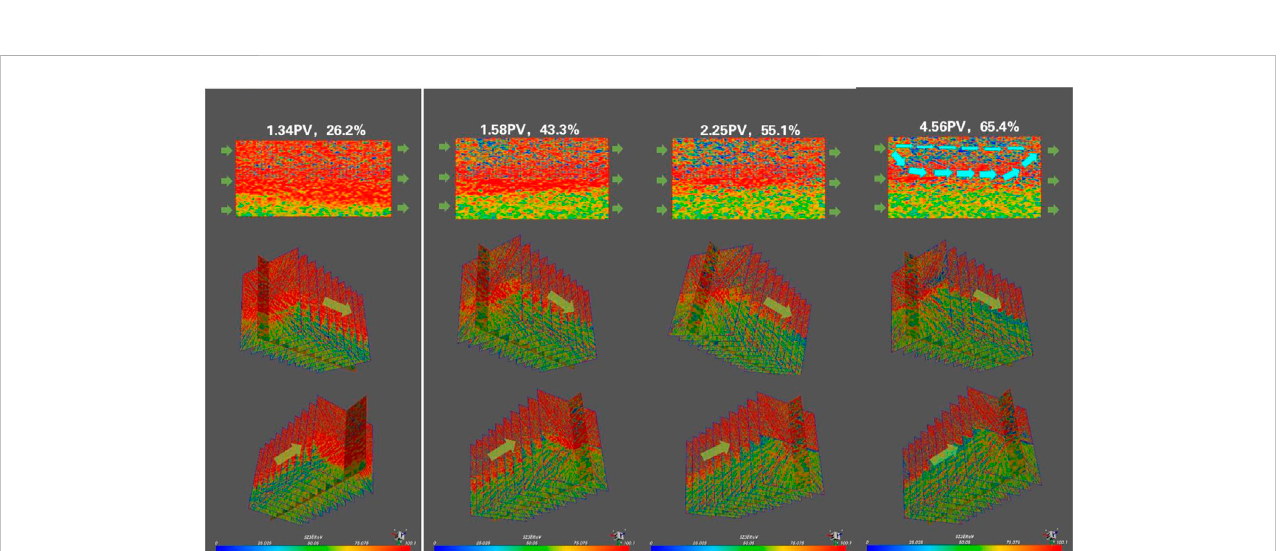
FIGURE 11 Oil saturation distribution in SZ3